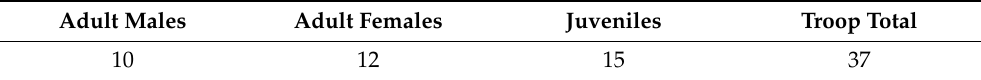
Table 2. Summary of population demographics. Adult